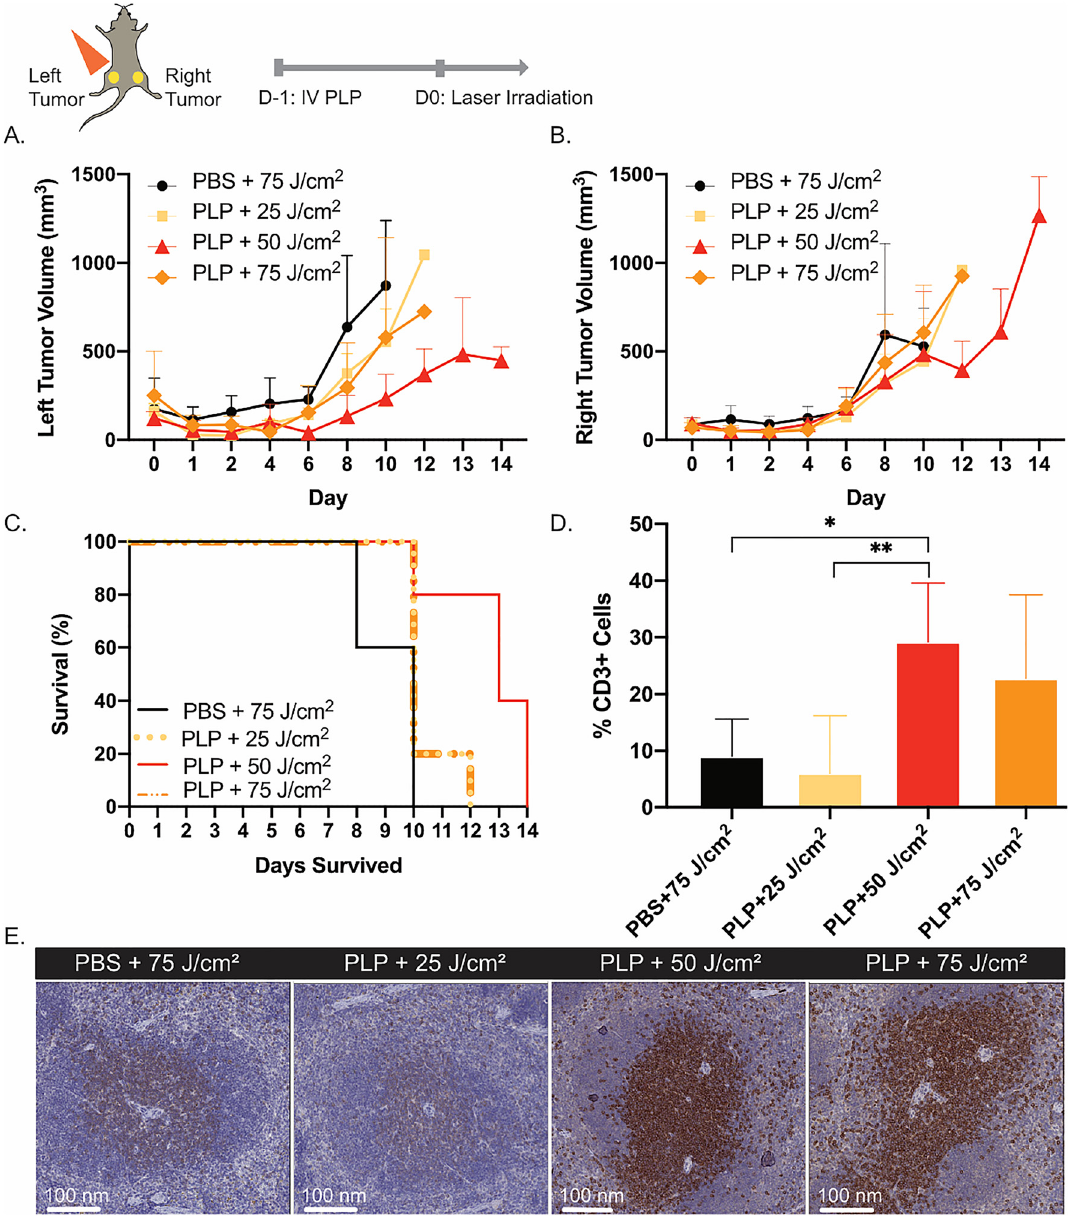
Figure 2: Optimization of light dosage for immune priming. (A)DualsubcutaneousAE17-OVA + tumorbearingmiceweretreatedwitheitherPBSorPLP(4mg/kg).Twenty-fourhourspost-injection,theleft hindlimb tumors on mice were irradiated with a 671 nm laser at a light dose of either 25 J/cm 2 , 50 J/cm 2 , or 75 J/cm 2 . Evaluation of tumor volumesofirradiatedlefthindlimbtumorvolumes( n =5).(B)Assessmentofnon-irradiatedrighthindlimbtumorvolumes( n =5).(C)Survivalof mice treated with either PBS + 75 J/cm 2 , PLP + 25 J/cm 2 , PLP + 50 J/cm 2 , or PLP + 75 J/cm 2 ( n = 5). (D) Histological analysis of the percentage of CD3 + T cells in spleens of mice harvested at time of endpoint ( n = 3). (E) Microscopic image of a CD3-stained spleen from one mouse in each treatmentgroup.Data aremean ± standarddeviation.Statisticalsigni fi cancewas determinedusinga one-wayANOVAfollowedby a post-hoc Tukey test. *p < 0.05, **p <